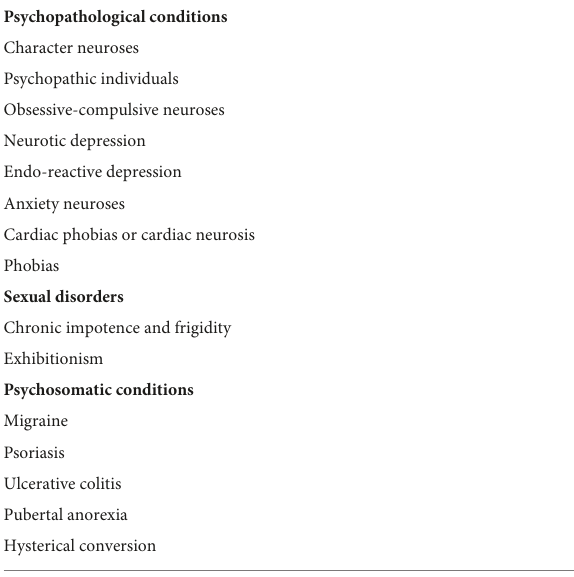
Psychopathological